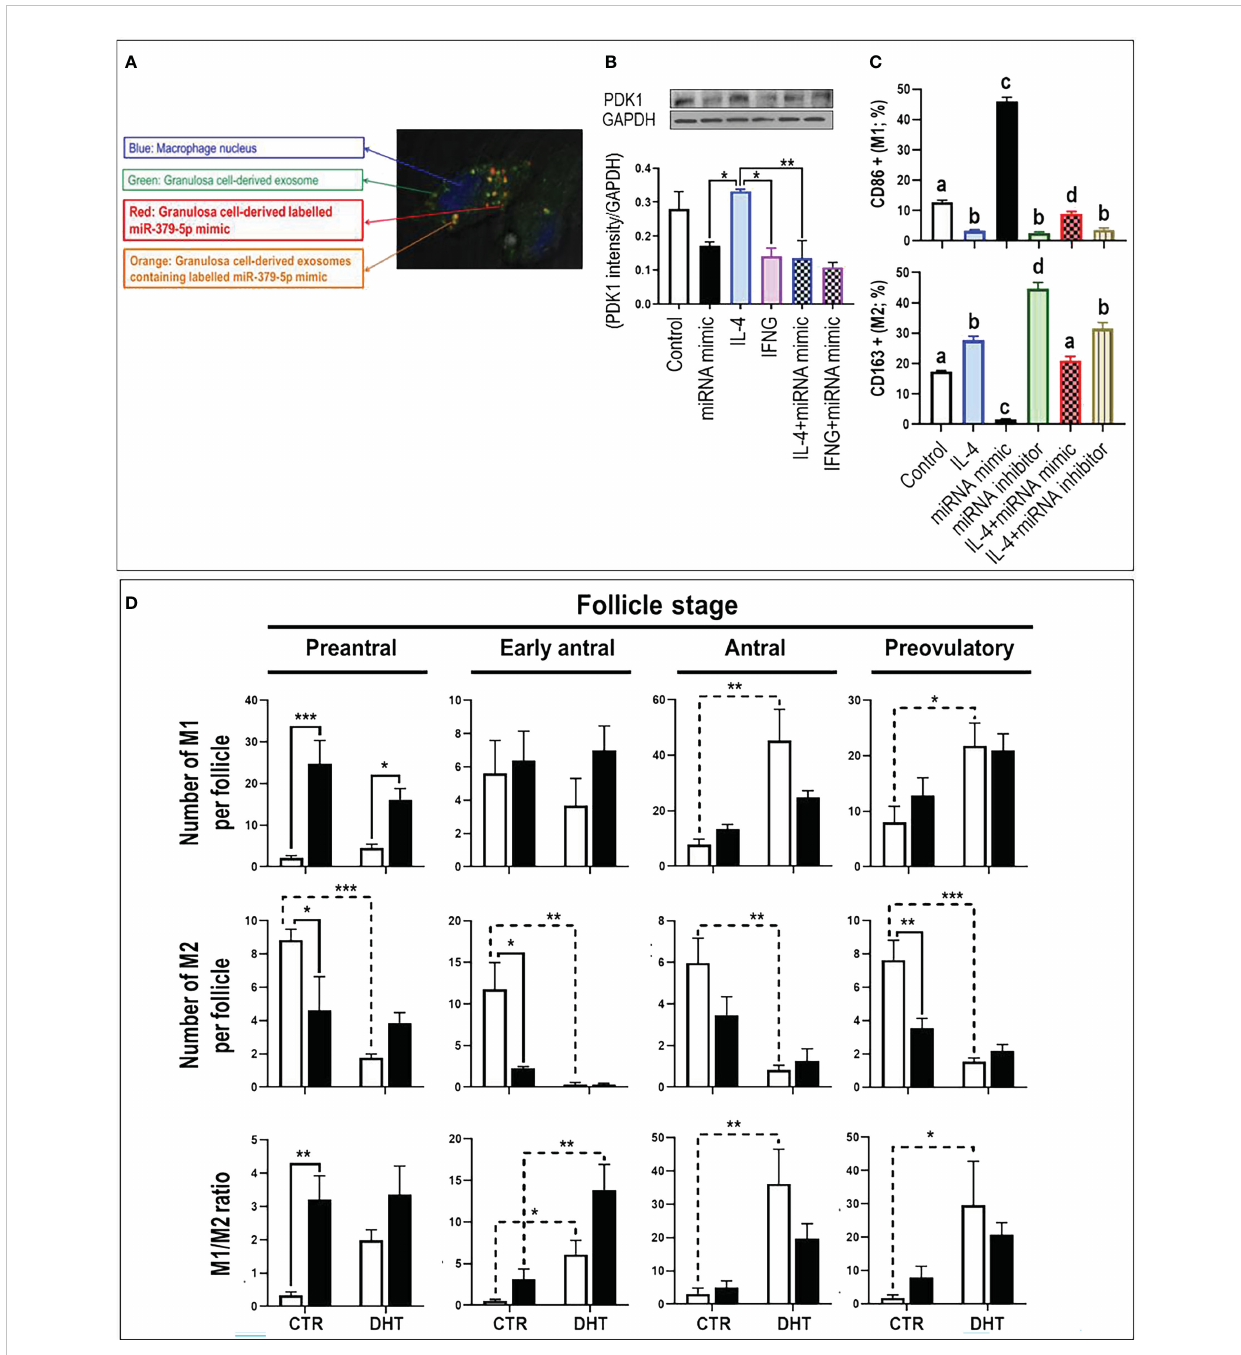
FIGURE 1 MiR-379-5p (miR379) increases M1/M2 ratio in preantral follicle stage by targeting PDK1. (A) Granulosa cells were transfected with CD63-GFP (green) and Alexa-647 labelled miR-379-5p (red), allowing the tracking of exosome and miR-379-5p in co-culture system. Tracking granulosa cell derived exosomes (green; GFP) and miR-379-5p (red; alexa-647) signals indicate that macrophages engulfs granulosa cell derived exosomes containing labeled miR-379-5p (orange). (B) IL4-induced M2 had greater PDK1 content compared to IFN g -induced M1. Pre-treatment of bone marrow derived macrophages with miR379 mimic alone or in combination with IL4 reduced PDK1 to a similar level of IFN g -M1. (C) miR379 polarizes macrophages towards M1. Transfection of macrophages with miR379 mimic polarized M0 to M1, a mechanism which was reversed by its inhibitor. (D) The ovarian miR379 overexpression increased M1 population in preantral follicles of both control and DHT rats. MiR379 overexpression signi fi cantly reduced M2 population in preantral, early antral and preovulatory follicles, increasing the M1/M2 ratio in control preantral follicles. Androgen excess increased M1 population in antral and preovulatory follicles, but reduced M2 population in all stages. The ratio of M1/M2 increased in early antral, antral and preovulatory follicles in response to androgen; Results are expressed as mean±SEM (n=3 replicates each with 2 rats/group). Data were analyzed by one-way ANOVA & tukey post hoc. *P<0.05; **P<0.01; ***P<0.001; (C) Different letters indicate signi fi cant differences between groups (P<0.05). To produce bone marrow derived macrophage, bone marrow cells were isolated from rat femur and tibia and differentiated to macrophages with M- CSF for 7 days in vitro. Granulosa cells were isolated from preantral follicles (diethylstilbestrol-primed immature rats; day 21, 1 mg/d, subcutaneously, for 3 consecutive days) and transfected with miR-379-5p mimic (mirVana mimics, MC10316, Thermo-Fisher; 18h) and were further cultured for 36h. Macrophages were polarized to M1 and M2 by LPS (10 r g/mL) + IFN- g (20 ng/mL) and IL-4 (20ng/mL) treatment for 36h,